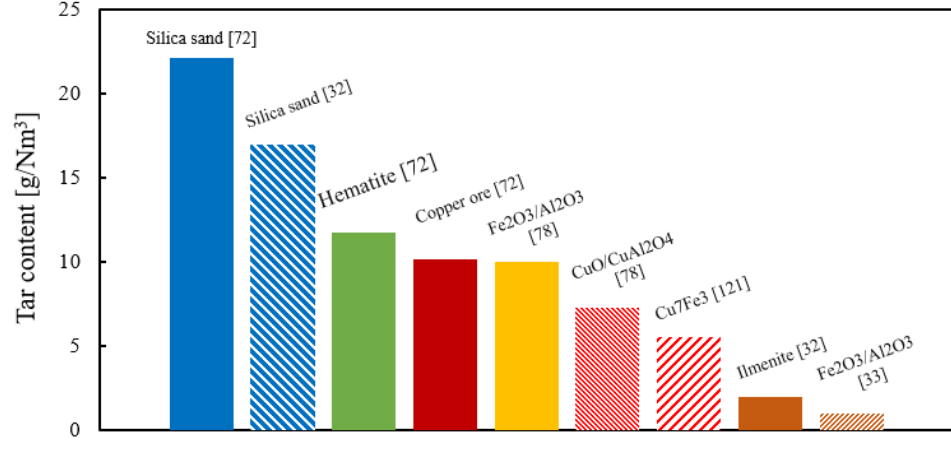
Figure 12. Tar yield (800 – 880 °C ).